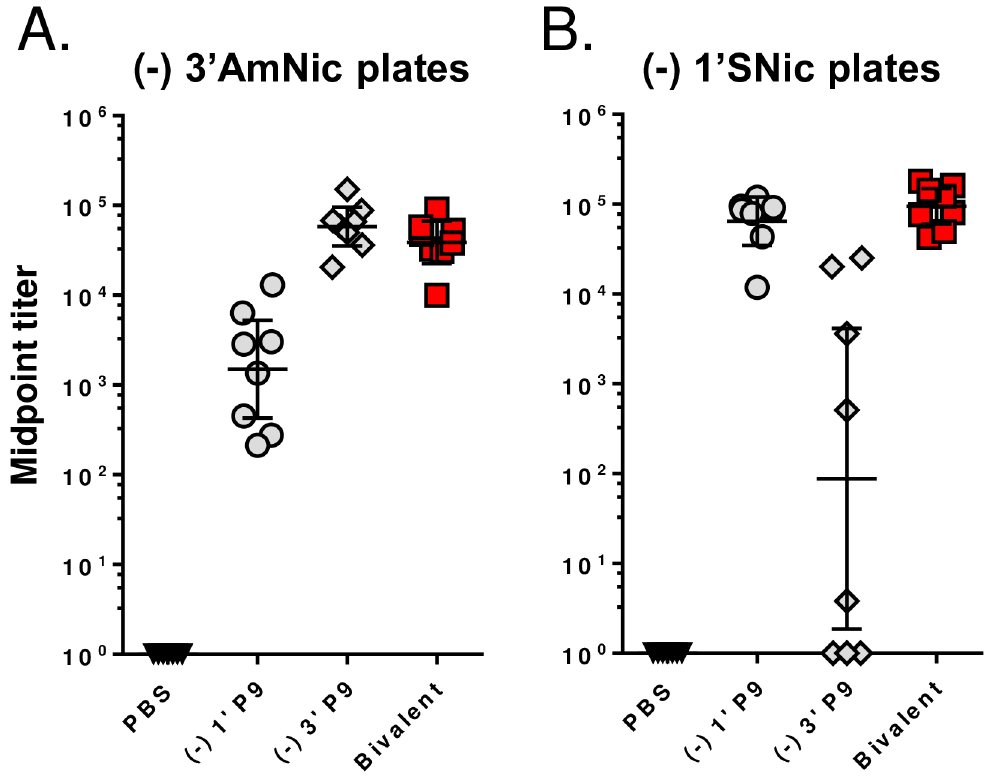
Fig 6. Antibody cross-reactivity between 1’-SNic and 3’-AmNic monovalent and bivalent vaccines. Serum was collected56 days after primingfrom mice immunizedwith: (1) 10 µ g (-) 1’ P9, (2) 10 µ g (-) 3’ P9 or (3) 5 µ g (-) 1’ P9 + 5 µ g (-) 3’ P9. Sera titers were assayed by ELISA using plates coated with (-) 3’-BSA (A ) or (-) 1’-BSA ( B)